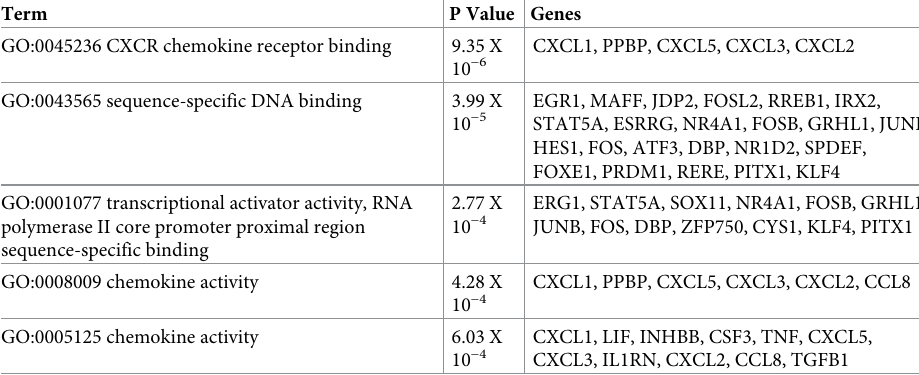
Table 1. GO analysis of the CAGE